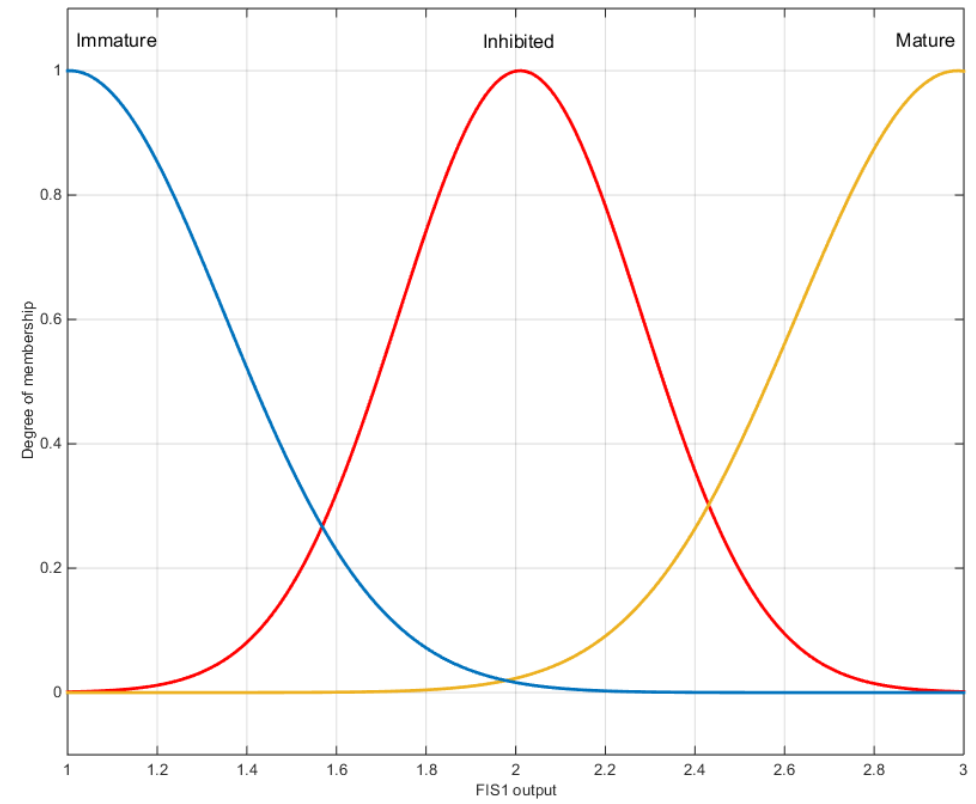
Figure 8. Membership functions of the fuzzy sets of the FIS1 system output.